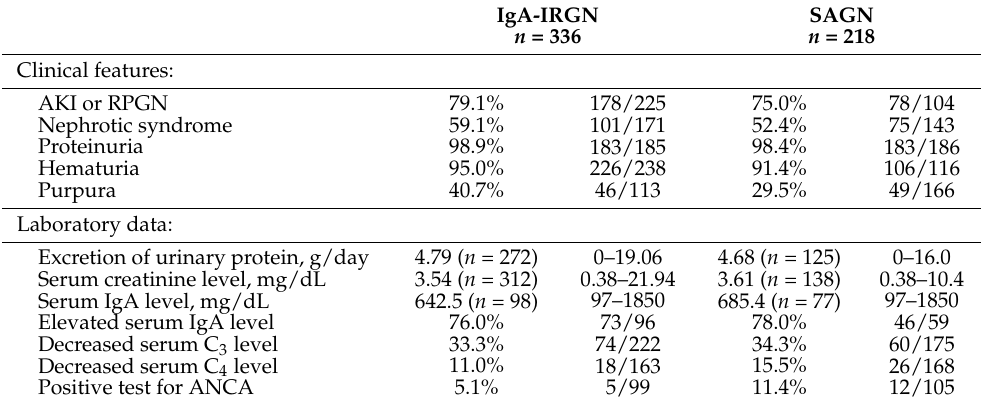
Table 3. Clinical features and laboratory data of the reported patients with IgA-IRGN or